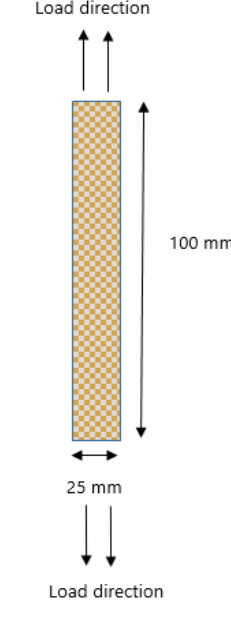
Figure 3. Tensile-load direction for KBF-treated MMA-esterification/ GF hybrid composite.